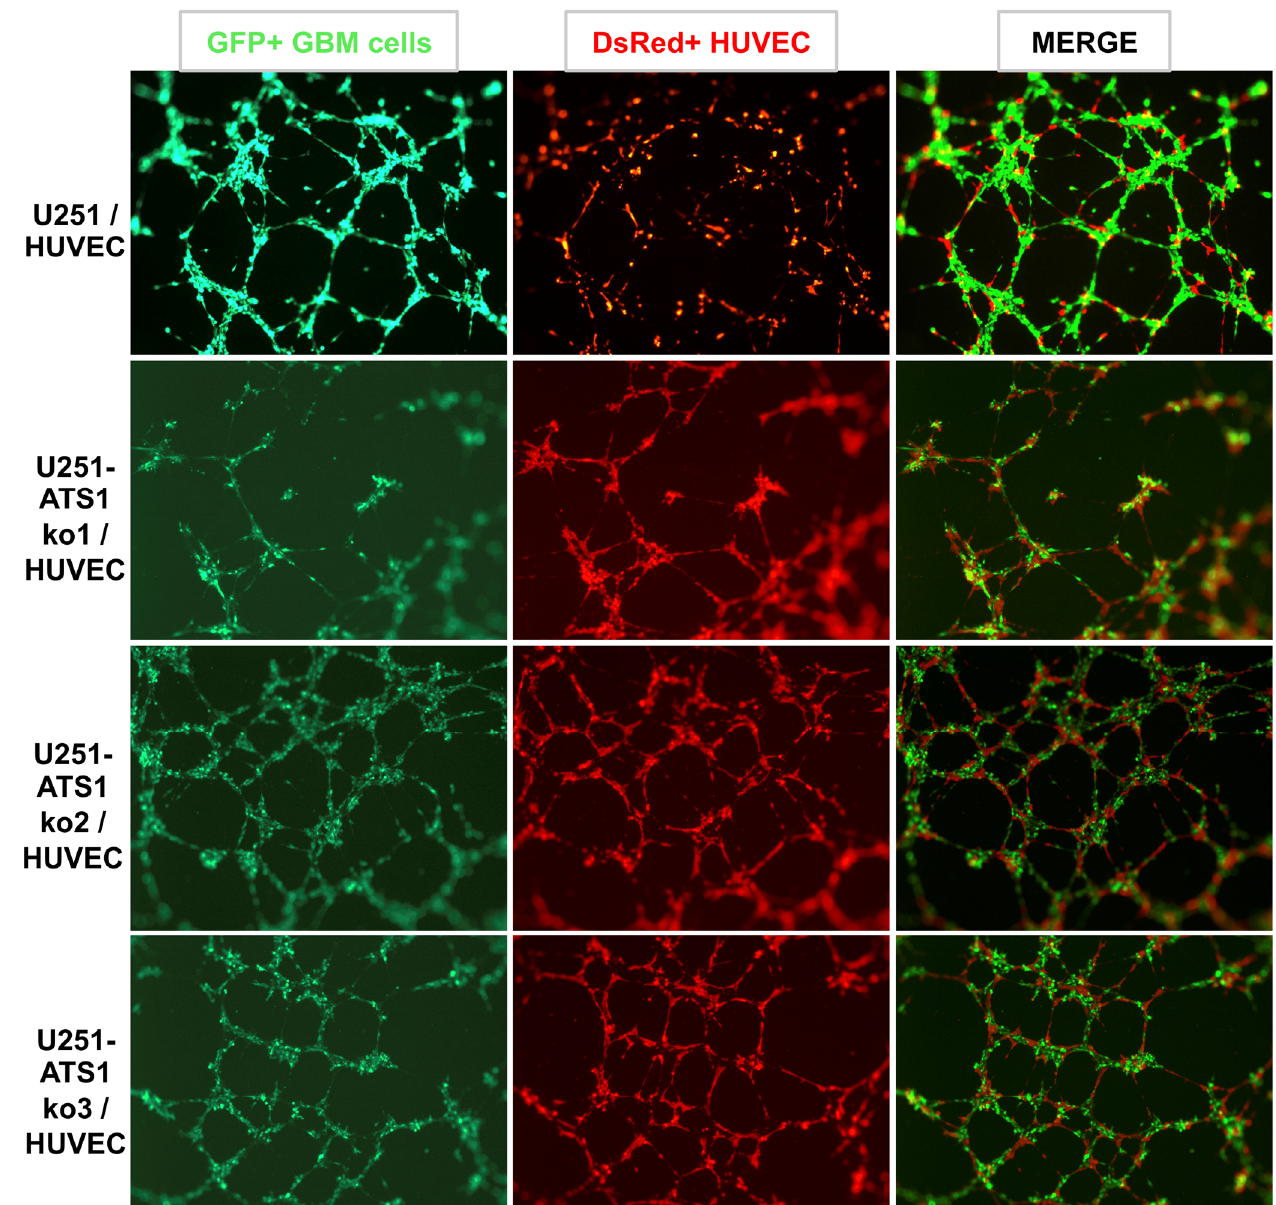
Figure 6. Effect of ADAMTS1 knockout in GBM cells co-cultured with HUVECs. Representative images of a co-culture Matrigel assay containing WT U251-MG (top row) or 3 U251-ATS1ko clones (second to fourth rows), co-cultured with HUVECs (second column, red). Third column is the resulting merge of U251 and